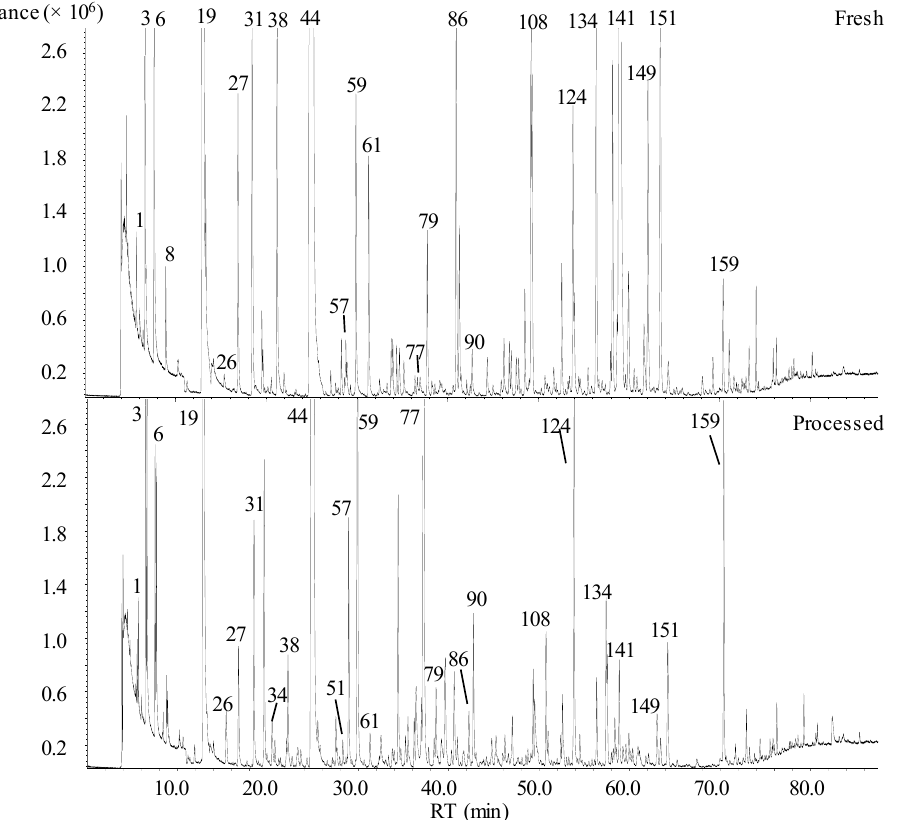
Figure 1. Total ion chromatograms obtained by the headspace solid-phase microextraction (HS-SPME) DVB/CAR/PDMS /gas chromatography-quadrupole mass spectrometry (GC-qMS) analysis of fresh and processed pear juice (for the identification of peak numbers, see Table